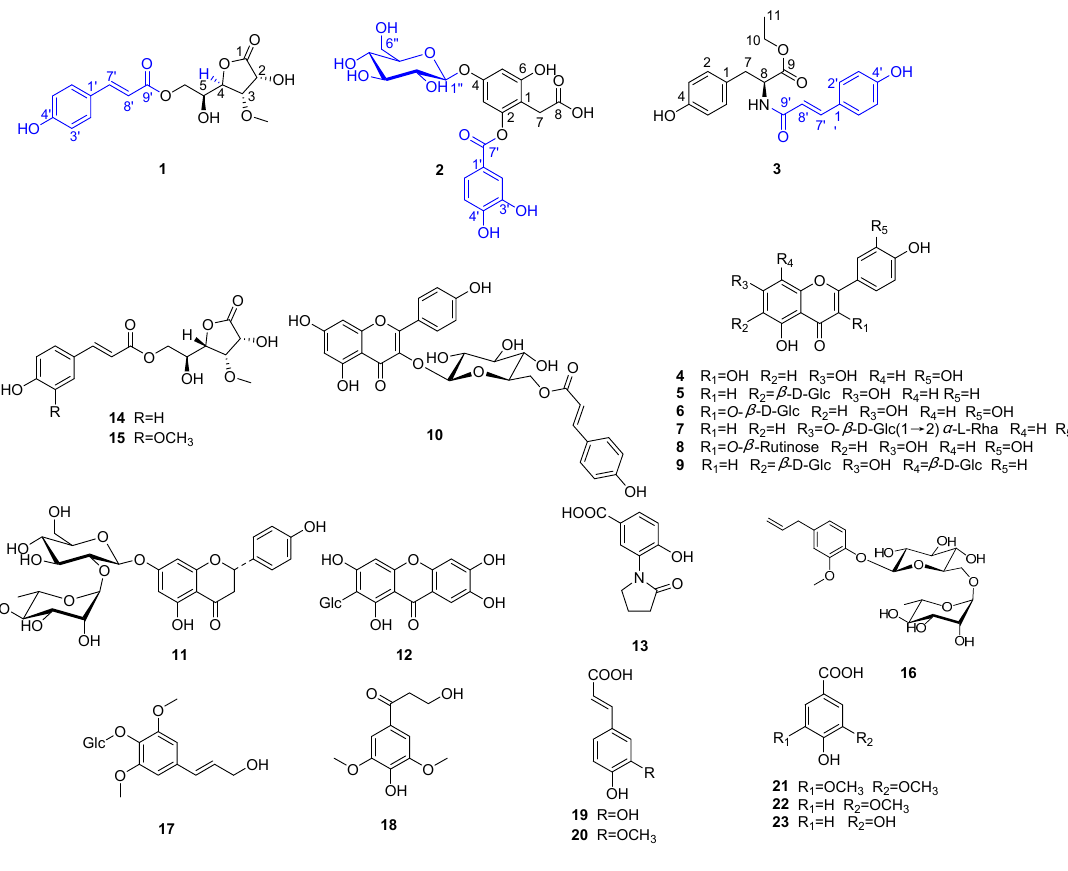
Figure 1. Chemical structures of 1 – 23 .